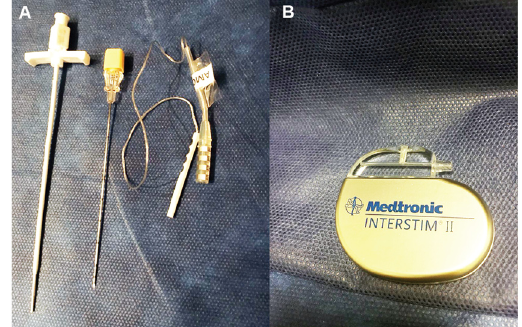
Figure 3. Sacral nerve neuromodulation. Courtesy of Lucia Oliveira, Rio de Janeiro,